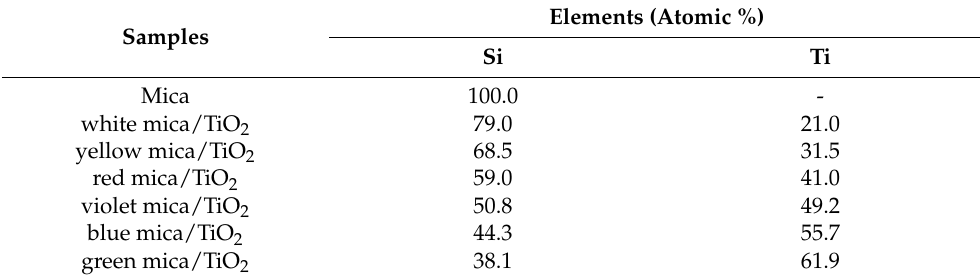
Figure 4. Cross-sectional FE-SEM images of ( a ) mica, ( b ) white mica/TiO 2 , ( c ) yellow mica/TiO 2 , ( d ) red mica/TiO 2 , ( e ) violet mica/TiO 2 , ( f ) blue mica/TiO 2 , and ( g ) green mica/TiO 2 prepared using a focused ion beam (FIB) system. Regions of Mica are marked as dotted orange lines (inset: low magnification FE-SEM images of cross-sectional samples). Table 1. Elemental compositions of mica and color mica/TiO 2 materials a .